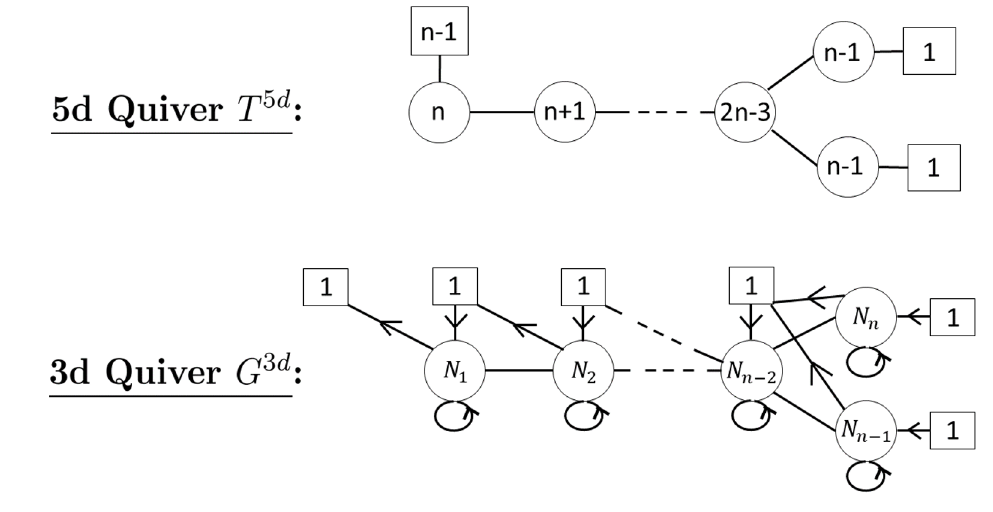
Figure 3. Sphere with 3 full D n punctures: 5d theory T 5d and 3d theory G 3d resulting from W S